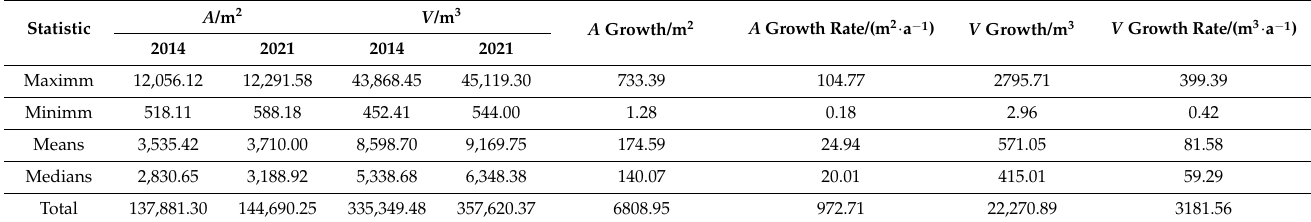
Table 4. Increments in area and volume of 39 gullies during 2014–2021.